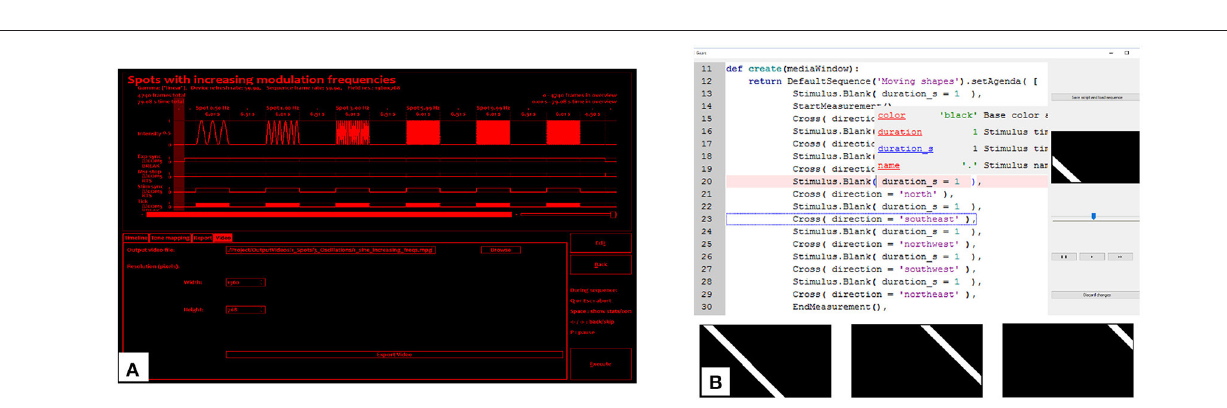
FIGURE 2 | The (A) sequence overview and (B) visually aided script editor of GEARS. Editable Python code of the stimulus sequence script is listed. Call tips displaying currently edited SBC parameters with their default values and descriptions are shown automatically. A seekable dynamic preview of the stimulus is also displayed while marking the part of the script under